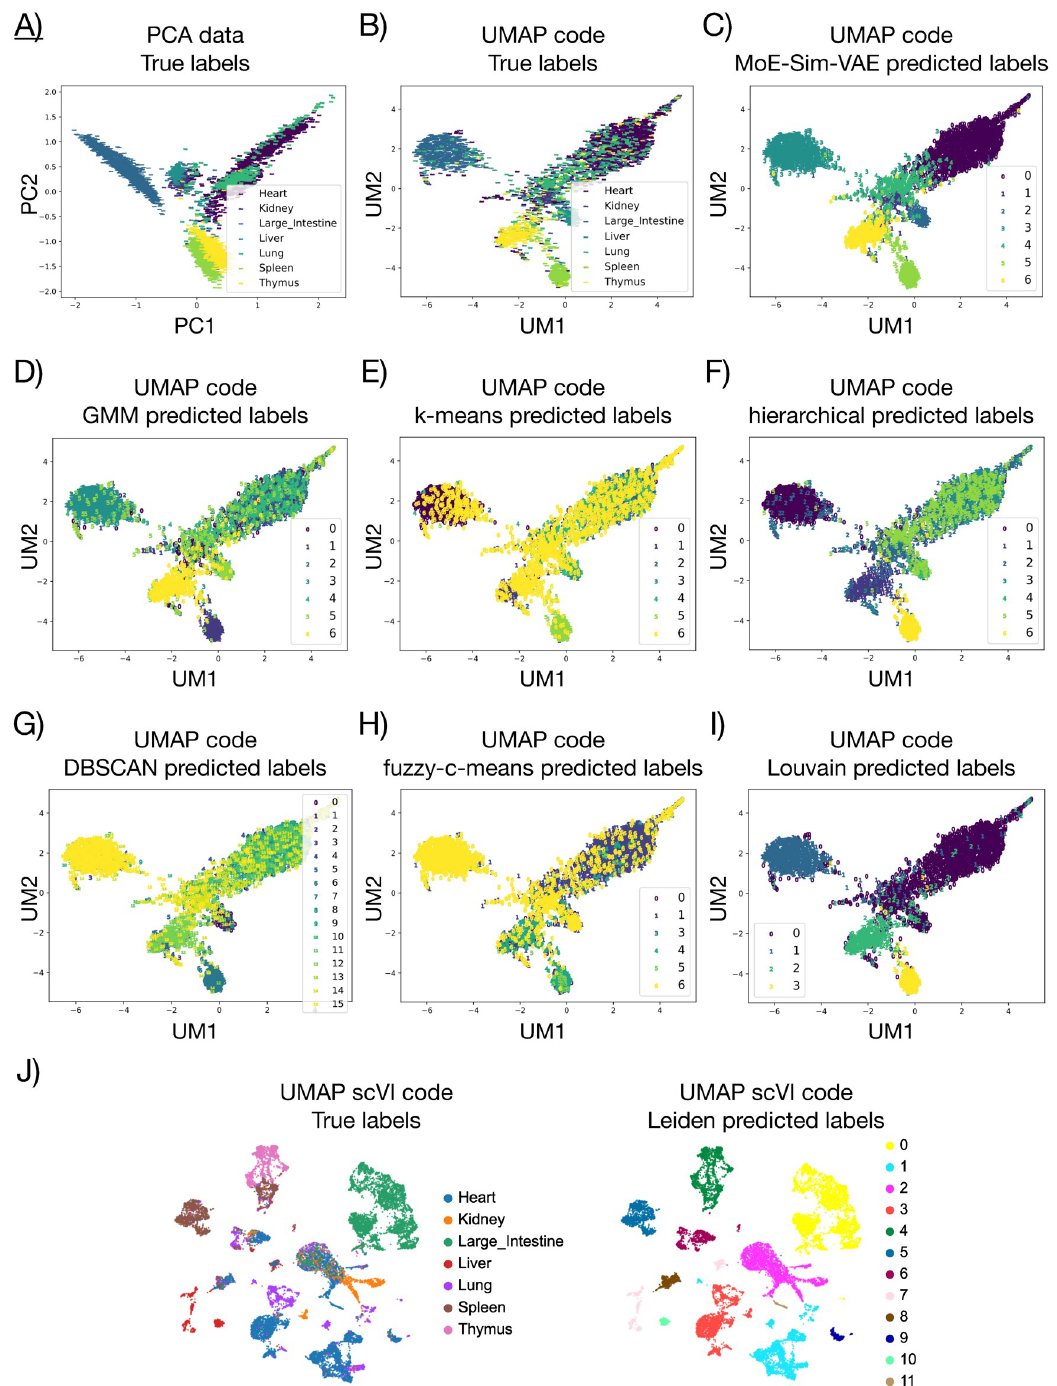
Fig 3. Results of clustering mouse organs from single-cell RNA-sequencing data. A) Principal Component Analysis of the original data with true labels. The remaining panels are UMAP representations of the latent representation inferred from MoE-Sim-VAE with B) true labels. C) predicted labels from MoE-Sim-VAE. D) predicted labels from Gaussian Mixture Model. E) predicted labels from k-means. F) predicted labels from hierarchical clustering. G) predicted labels from DBSCAN. H) predicted labels from fuzzy-c-means. I) predicted labels from Louvain. J) true and predicted labels on scVI inferred latent representation using Leiden clustering.